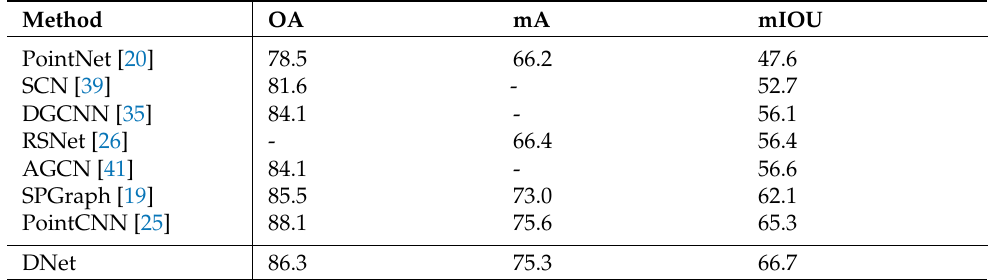
Table 5. Scene segmentation results on S3DIS dataset evaluated with 6-fold cross validation (%).